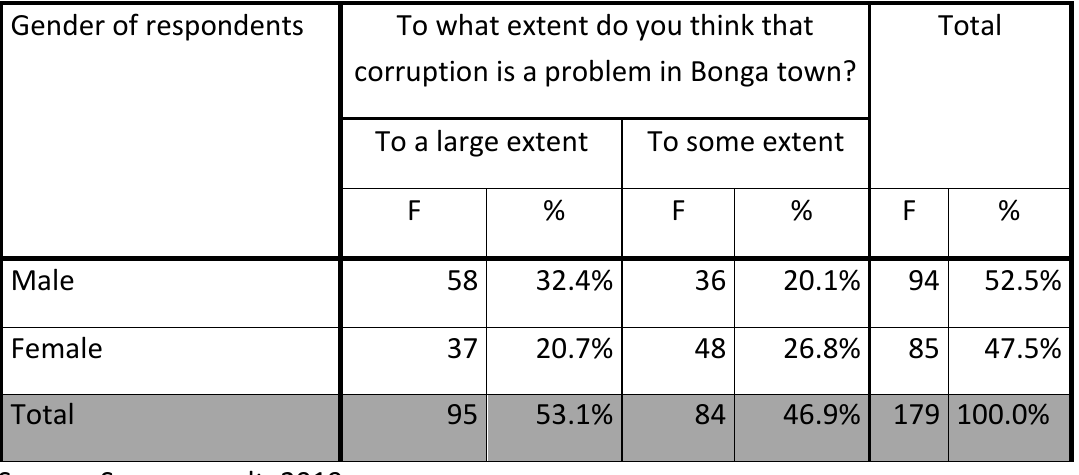
Table 16: The extent to which corruption is a problem in the